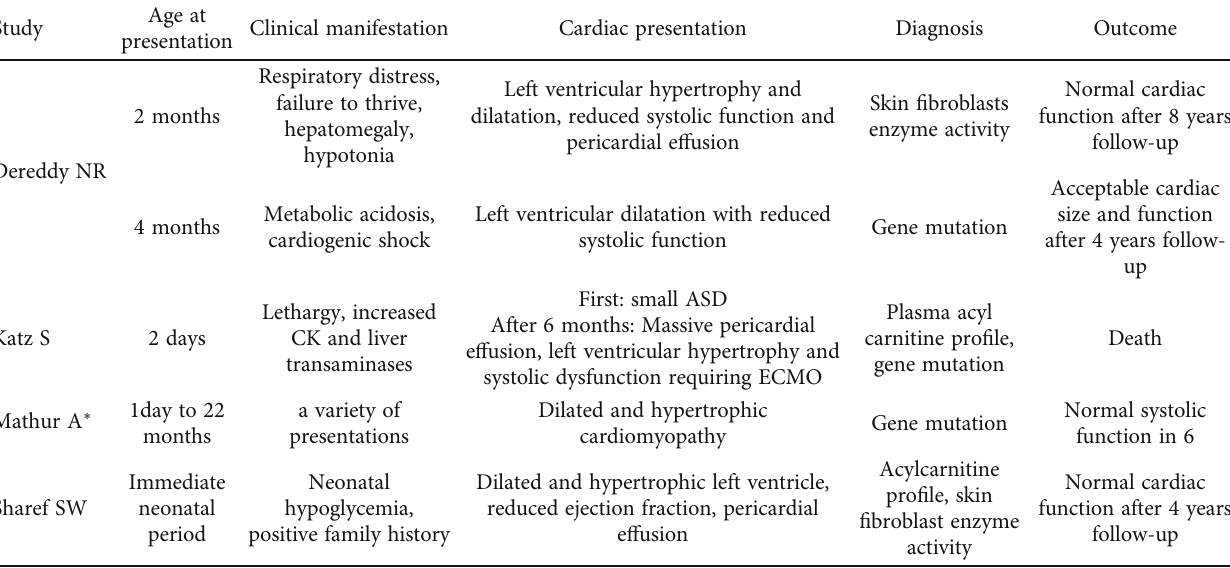
Figure 1: Echocardiographic evaluation at parasternal Log axis (a) and short axis (b) views shows left ventricular dilatation and decreased contractility. Table 1: VLCADD patients ’ natural